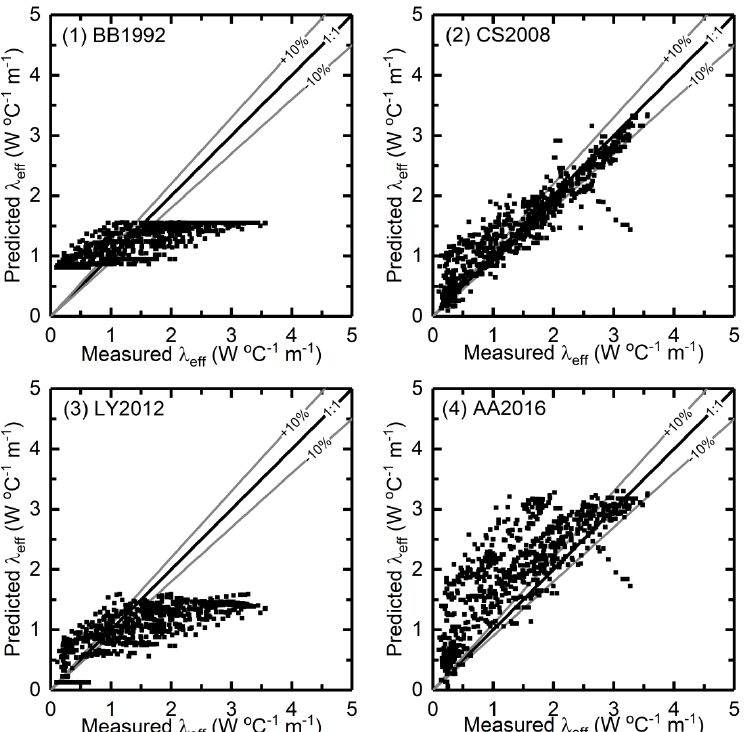
Figure 3. Comparison of measured λ eff and predicted λ eff with four linear or non-linear regression models: ( 1 ) BB1992 [27], ( 2 ) CS2008 [15], ( 3 ) LY2012 [28] and ( 4 ) AA2016 [17].